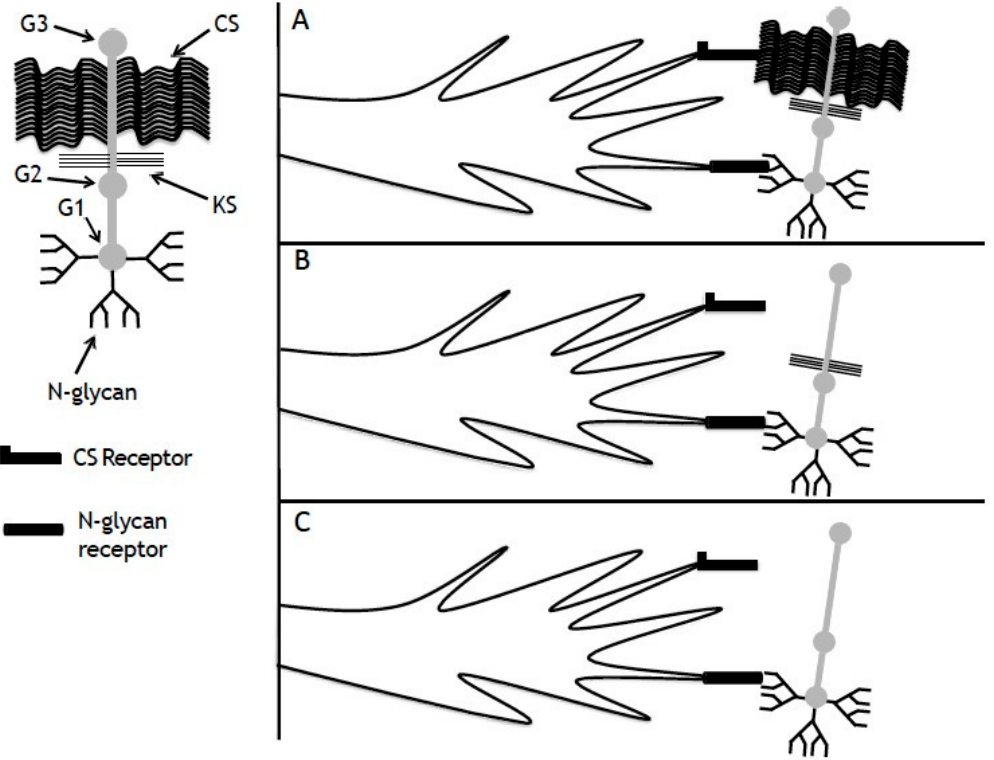
Figure 7. Effect of aggrecan post-translational modifications on neurite outgrowth. (A ) In the presence of intact aggrecan there is reduced maximal growth when compared to growth on collagen, likely due to the activation of CS receptors and receptors for N-glycans. ( B ) Removal of CS abolishes some inhibition, but there is no apparent effect of further removal of KS ( C ), suggesting no KS-receptor interaction. Removal of N-glycans following CS and KS removal abolishes inhibition, suggesting an interaction of N-glycans with a receptor on the growth cone.